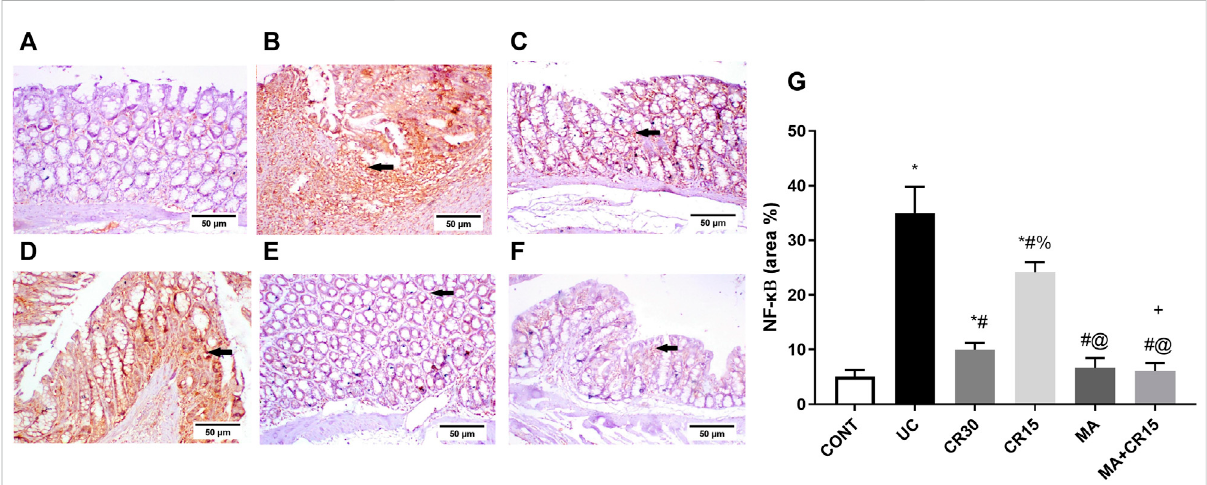
FIGURE 7 Effect of mirabegron and/or carvedilol on colon NF- κ B immunoreactivity in rats with IAA-induced ulcerative colitis. Panels (A – F) represent colonphotomicrographsofNF- κ Bimmunoreactivity(scalebar,50 μ m).Sectionof (B) UCmodelshowsstrongpositiveimmunostainedcells,relative to the (A) CONT group that shows no immune expression. Treatment with (D) CR15 reduced the number of immunostained cells, whereas the section of (C) CR30 lessened it markedly. Sections of (E) MA and (F) MA+CR15 treated groups show a weak immune expression (arrows). (G) shows the % area of NF- κ B staining (5 fi elds in each section). Data are presented as mean ± SD (n = 3). Statistical analysis was carried out using one- way ANOVA followed by Tukey ’ s posthoc test; p < 0.05. As compared to the (*) CONT, (#) UC, and (@) CR15. (+) additive interaction using CDI. CDI: coef fi cient of drug interaction; CONT, control; CR, carvedilol; IAA, iodoacetamide; MA, mirabegron; NF- κ B, nuclear factor kappa B; UC, ulcerative colitis.